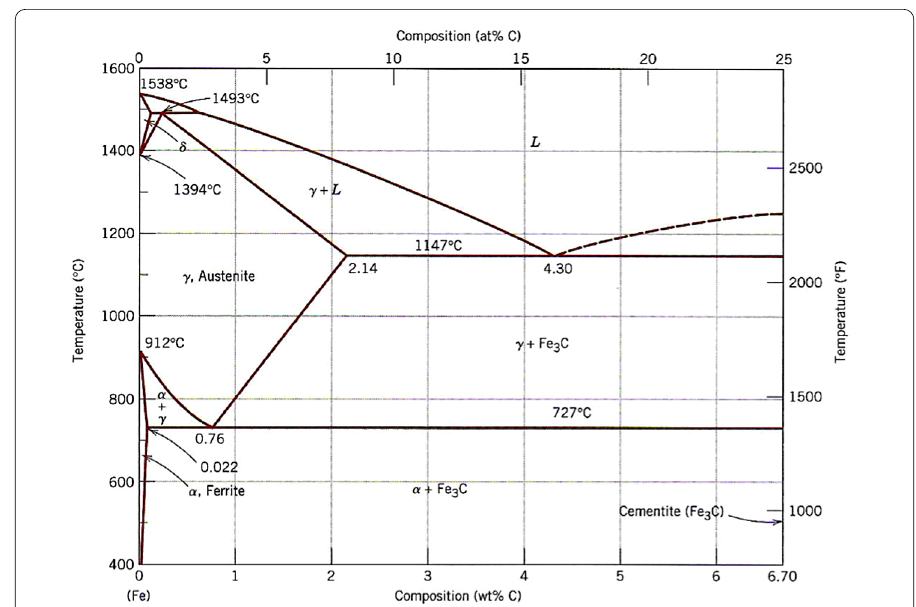
Figure 4 Equilibrium phase diagram for the Fe–C